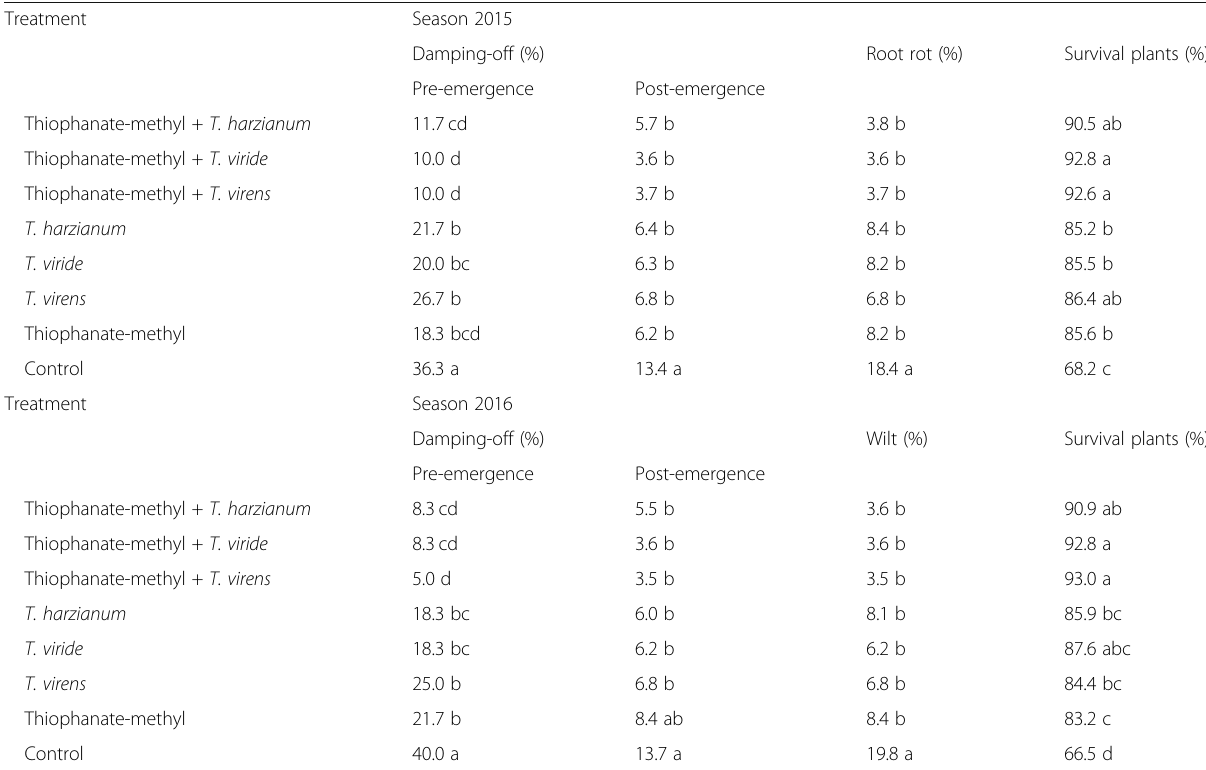
Table 3 Effect of soil application with Trichoderma spp. and seed coating with thiophanate-methyl employed either alone or in combination on damping-off, root rot/wilt, and survival dry bean plants grown under field conditions